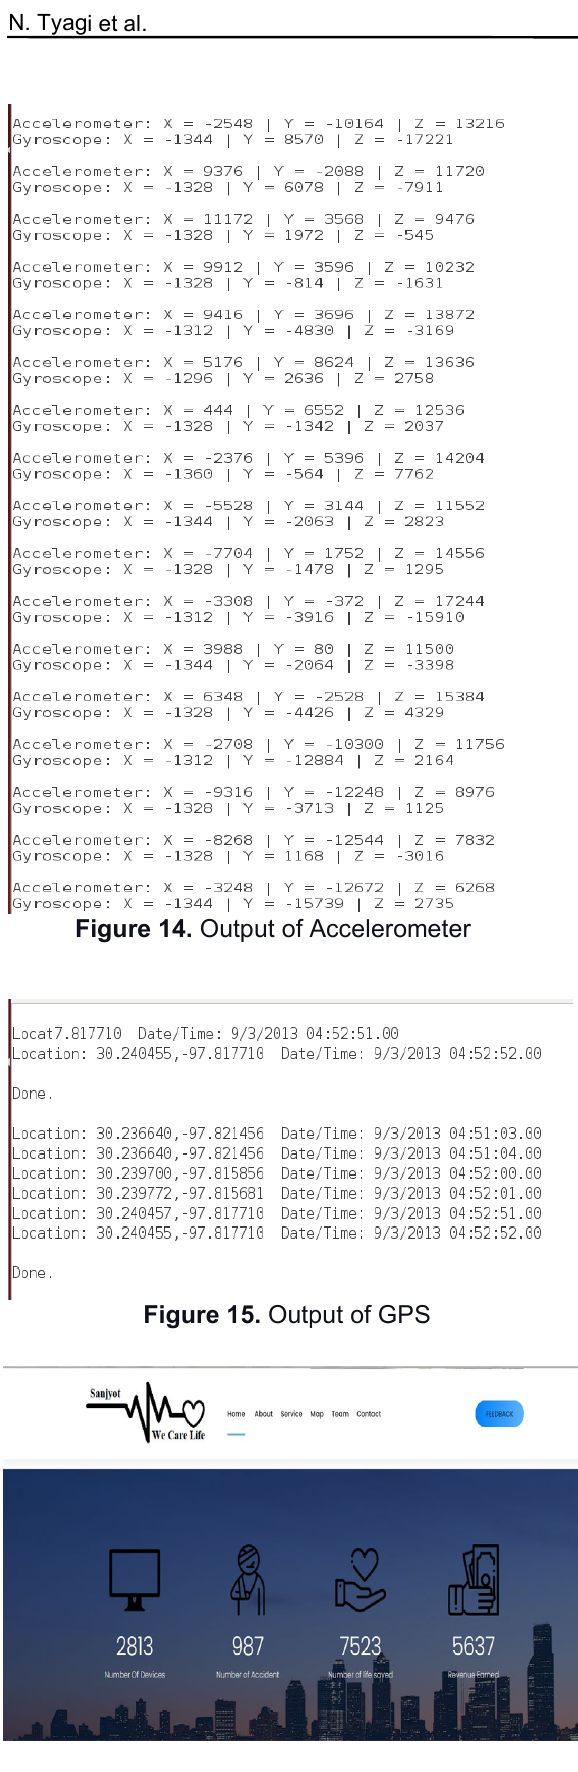
Figure 16. Analysis of data